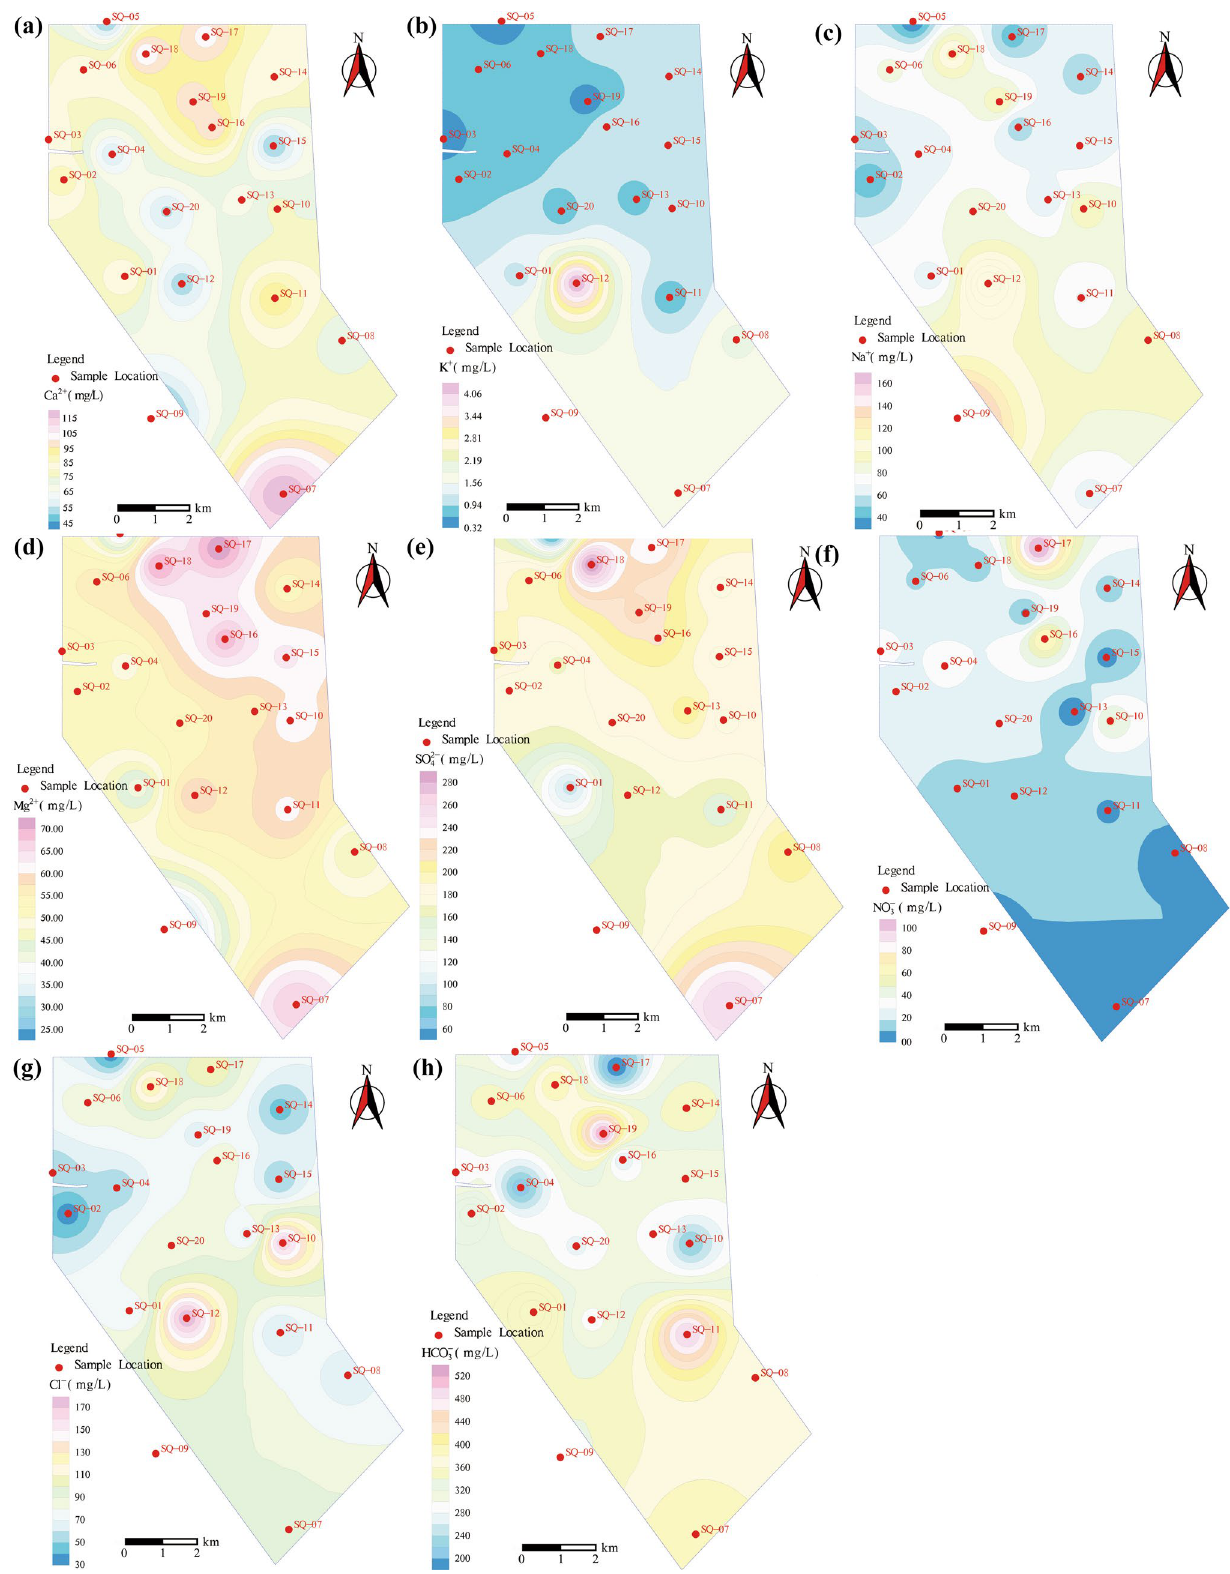
Fig. 2 Spatial distribution map of main ions: (a) Ca 2+ , (b) K + , (c) Na + , (d) Mg 2+ , (e) SO 42− , (f) NO 3− , (g) Cl − , and (h) HCO